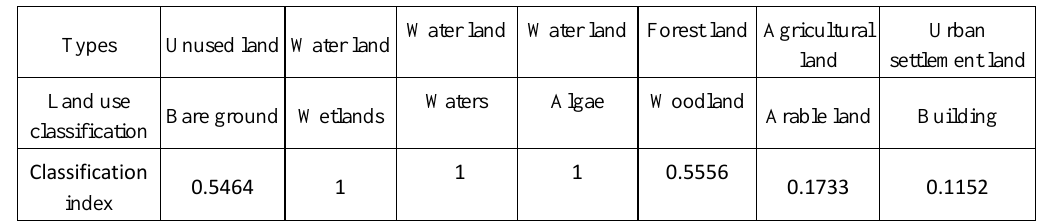
Table1 Chaohu Lake various land types of LDI weights